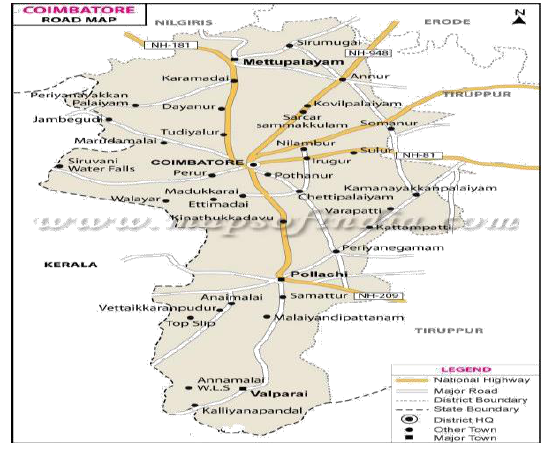
Figure 3: Coimbatore road map